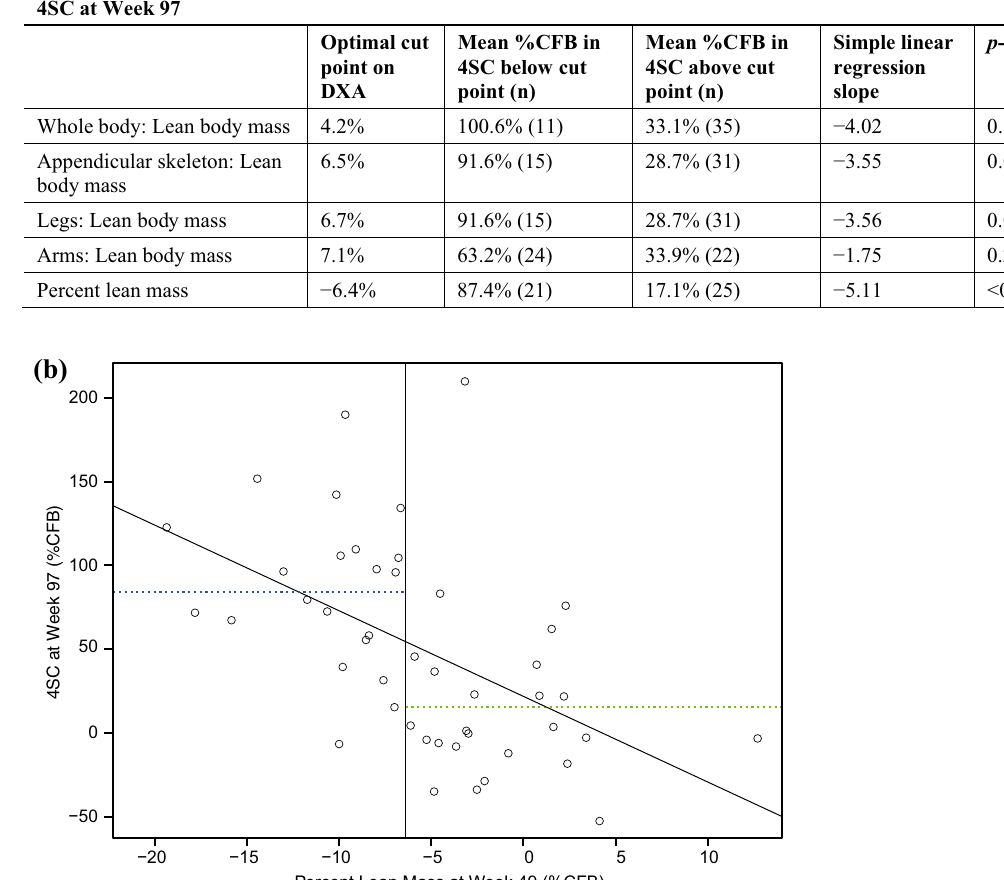
Table 3. Comparison of DXA change from baseline at Week 49 versus 4SC at Week 97. ( a ) Linear regression analysis of DXA %CFB at Week 49 versus 4SC at Week 97 in the overall population, and ( b ) example regression scatter plot showing the relationship between percent lean mass at Week 49 and 4SC at Week 97. In ( b ), the vertical line is the optimal cut point, the blue dotted line is the average response below the cut point, the green dotted line is the average response above the cut point, and the diagonal line is the simple linear regression fit. %CFB, percent change from baseline; 4SC, 4-stair climb; DXA, dual-energy X-ray absorptiometry; n, number in